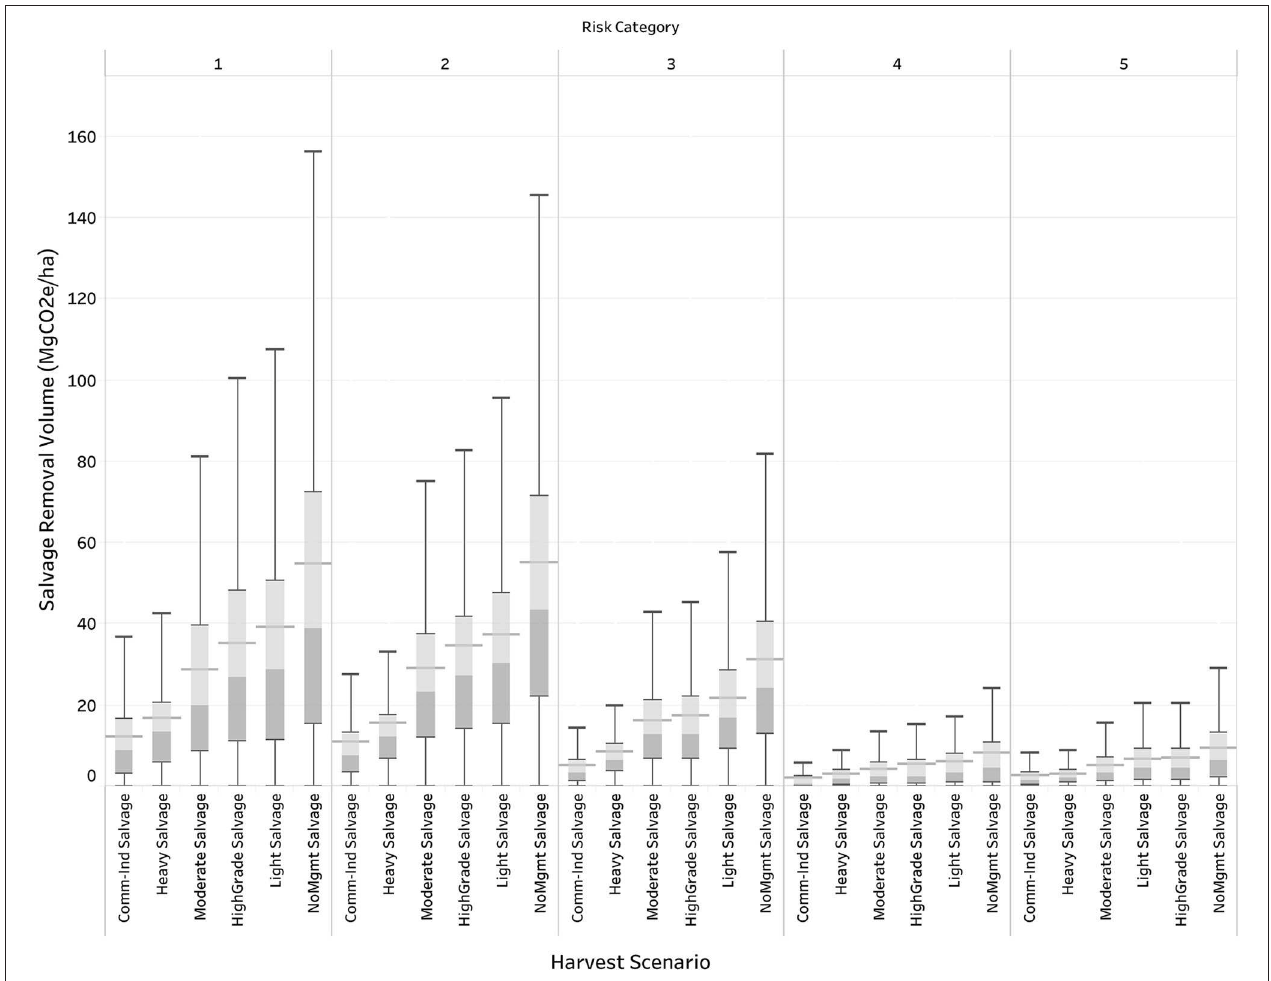
FIGURE 5 | Modeled salvage harvest removal volume (in MgCO2e/ha) for all management scenarios (excluding harvest volume prior from baseline harvest scenario). Mean is indicated by horizontal bar. Light gray color indicates upper hinge (75th percentile, Tukey’s inclusionary hinge), dark gray indicates 25th lower hinge (25th percentile, Tukey’s inclusionary hinge). Whiskers denote all data points within 1.5 times the interquartile range.